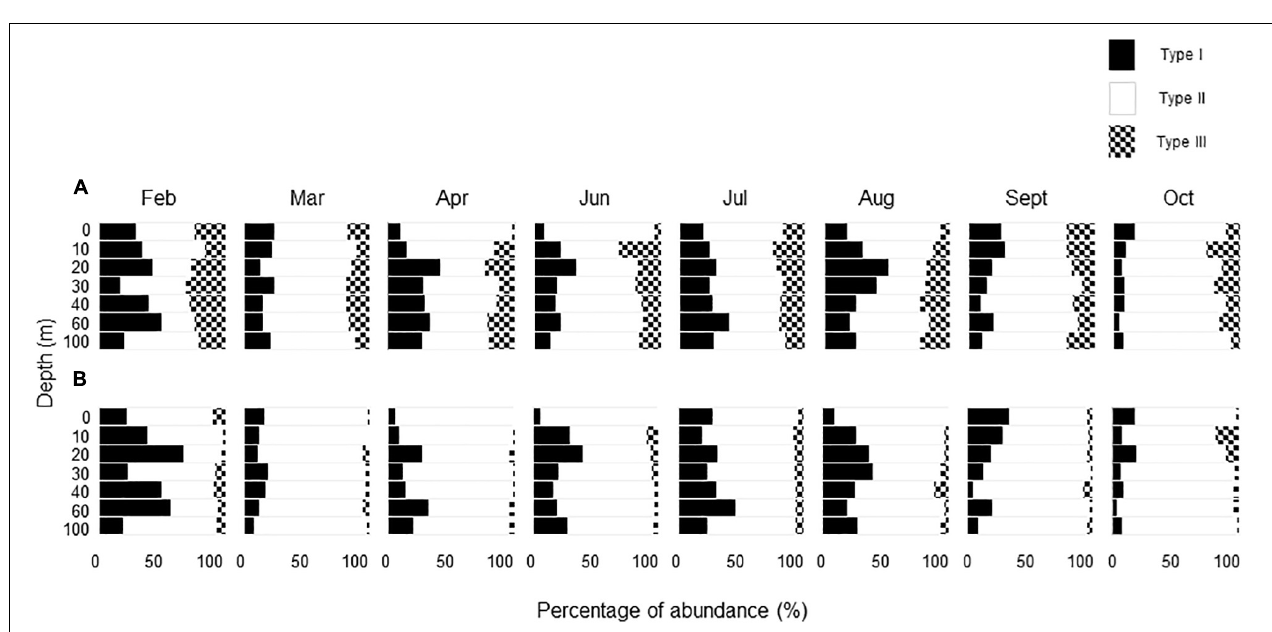
FIGURE 2 | Seasonal changes in vertical distribution of transparent exopolymer particle (TEP) abundance, expressed as (A) number (particles L − 1 ) and (B) area ( µ m 2 L − 1 ). Errors are ranges of estimates obtained using duplicate microscopic slides ( n = 2). The top half of each error bar is given for clarity.